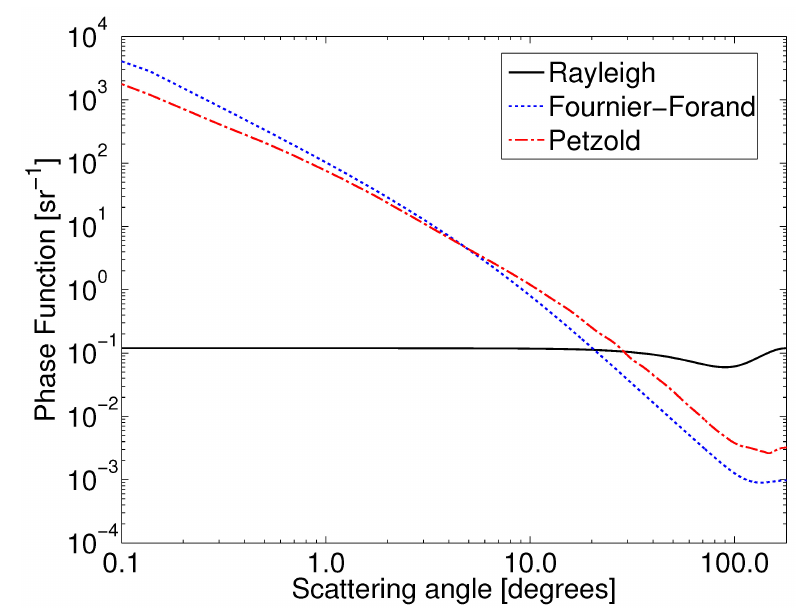
Figure 2. Rayleigh, Fournier-Forand, and Petzold scattering phase functions used to represent scattering by water molecules, pigmented particles, and non-algal particles, respectively, in the CCRR bio-optical model. To generate the FF scattering phase function the values ξ = 3.38 and ˜ m r = 1.068 were